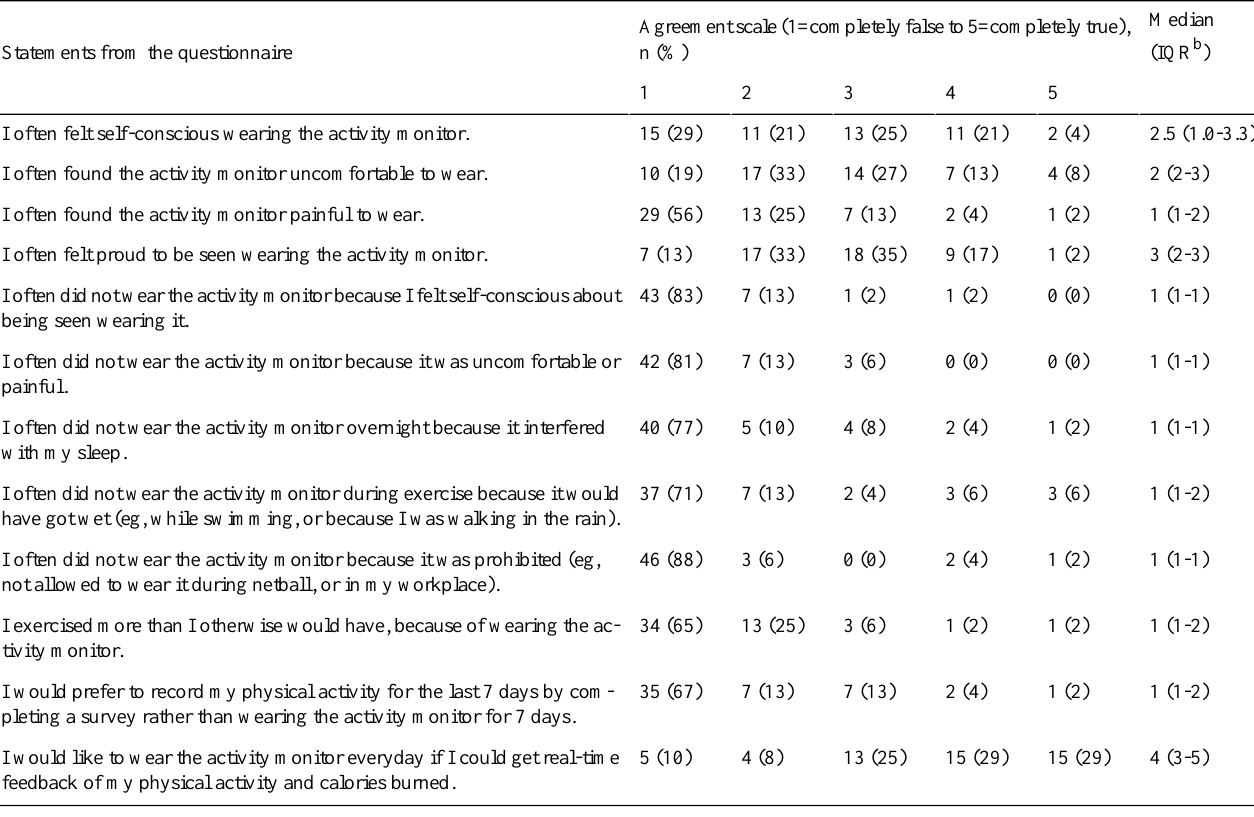
Table 2. Participants’experiences of using the SenseWear Armband (n=52) a .